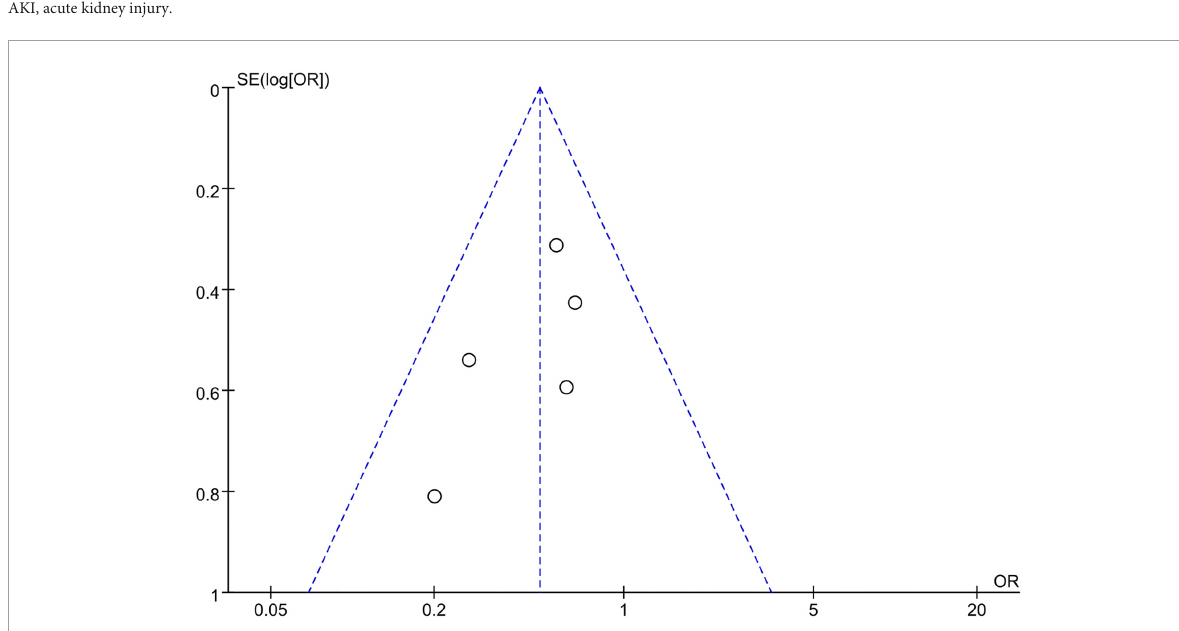
FIGURE2 Heterogenicity of included studies by the funnel plots.